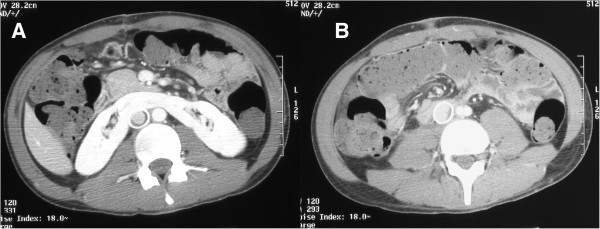
Follow up imaging. The control CT at 1 year (A and B) demonstrates the absence of the lesion and the patency of the prosthesis.